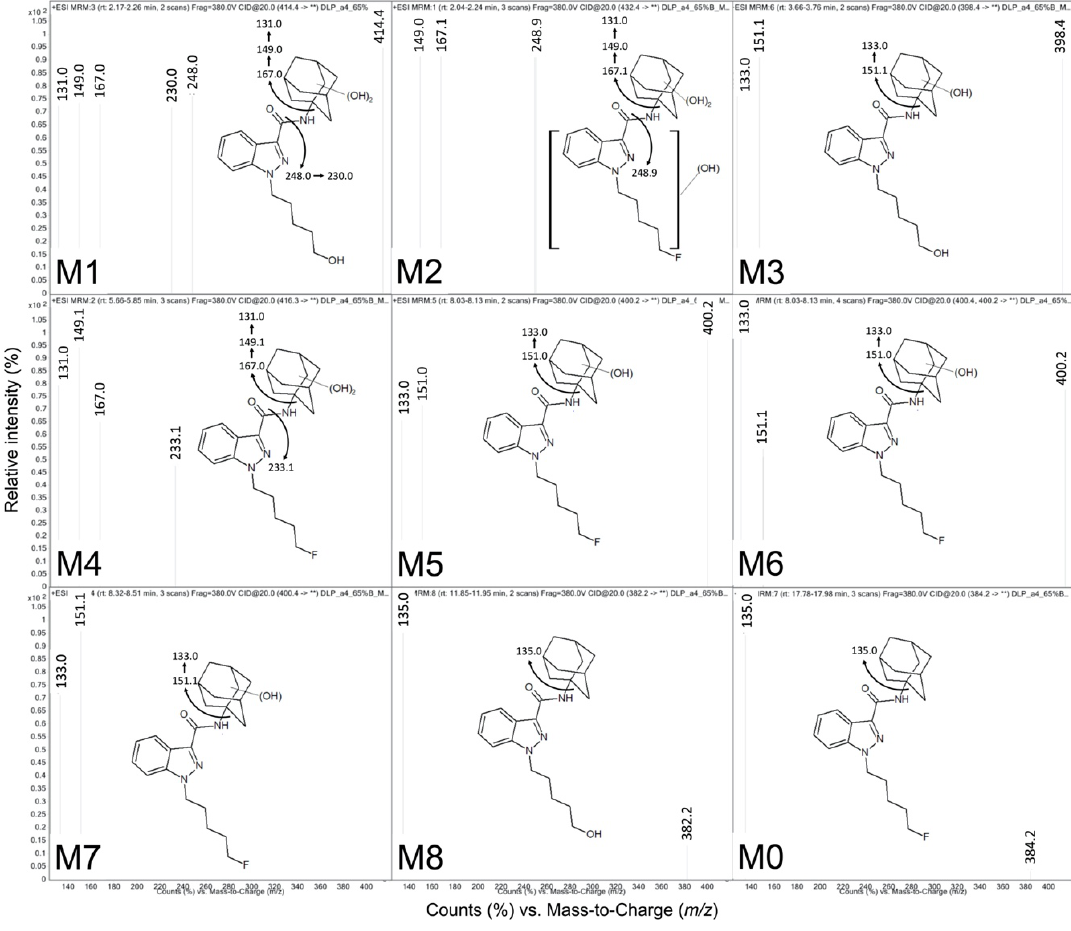
Figure 2. MS fragmentation spectra for 5F-APINACA metabolites and proposed structures. We resolved and analyzed metabolites from a 200 μM 5F-APINACA reaction to characterize their structures using an Agilent Technologic 1290 Infinity HPLC equipped with a 6490 Triple Quad